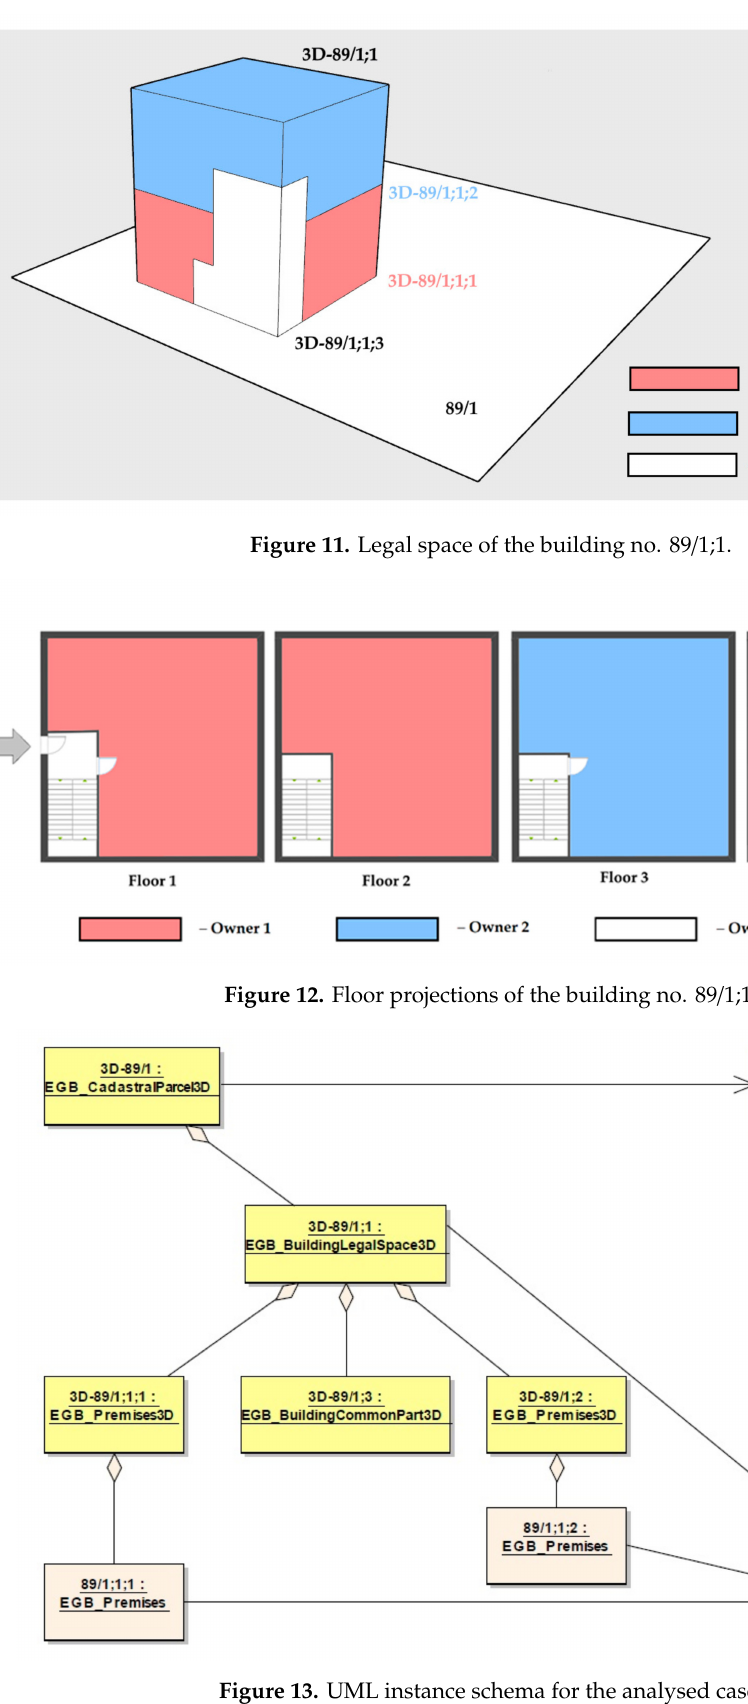
Figure 13. UML instance schema for the analysed